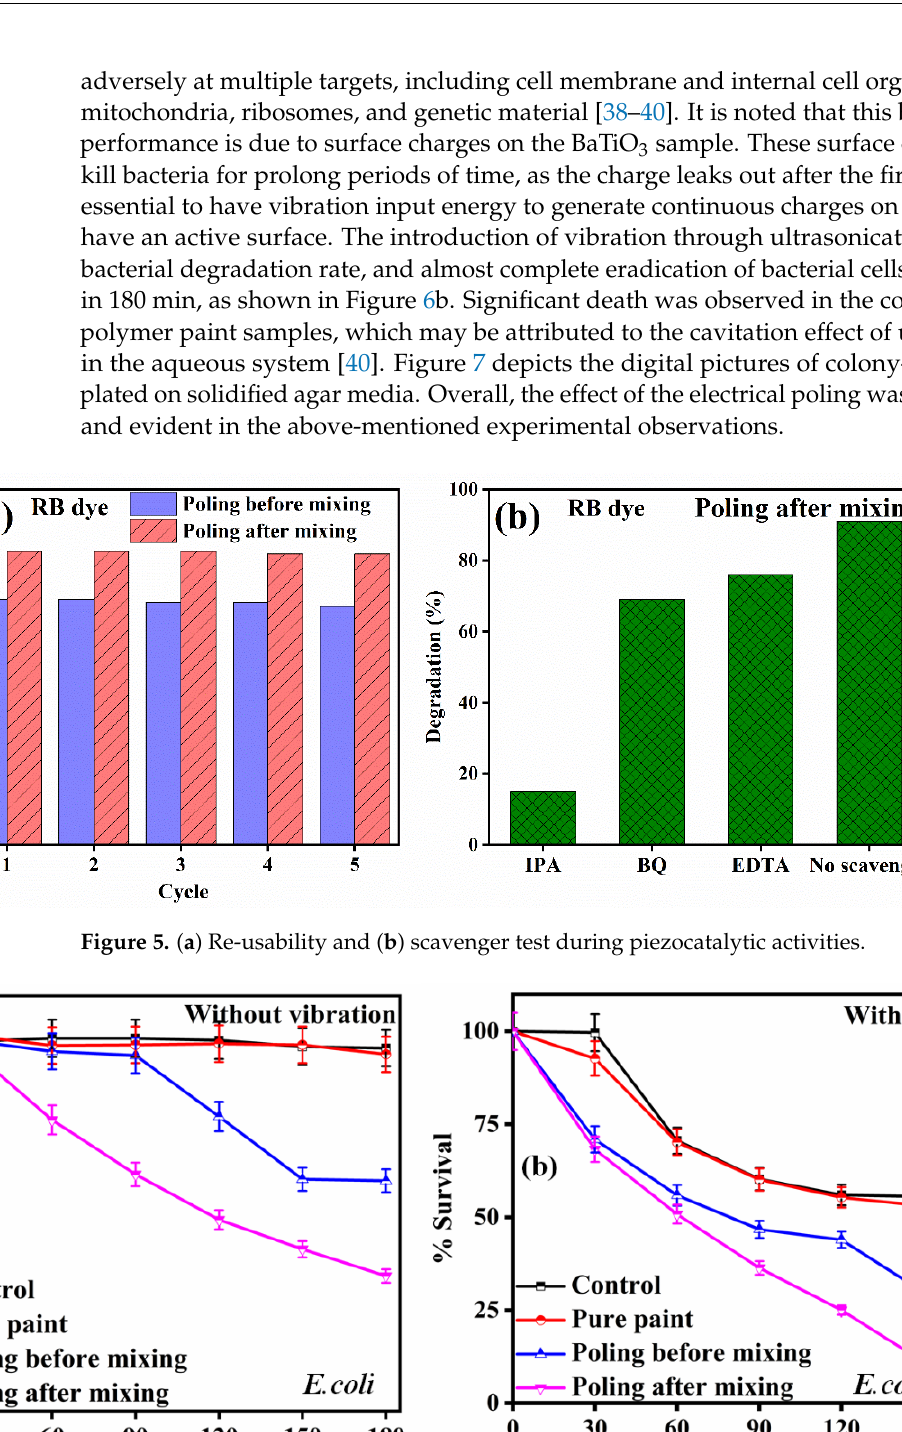
Figure 7. Real-time images of E. coli bacteria cell colonies after 180 min. 3. Experimental Ferroelectric BaTiO 3 (BT) was prepared using a solid-state reaction route. High purity reagents (AR grade, Merck chemicals, Mumbai, India) of BaCO 3 (99% pure) and TiO 2 (99% pure) powders were taken as the raw materials. The mixture was calcined at 1050 °C for four hours to obtain the single-phase BaTiO 3 . The phase formation characterization of the calcined sample was done using the powder X-ray diffraction (XRD) technique employing Cu- Kα radiation (Smartlab, Rigaku , Tokyo, Japan). Polymer (Asian, white paint (50 wt.%)) and BaTiO 3 (50 wt.%) composite samples were prepared. Composite paste was painted (using a brush) on a rectangular frame. A structural study of cement-based composites was performed through X-ray diffraction (Rigaku Smart Lab, Tokyo, Japan) and a scan- ning rate of 2°/min for 2θ ranging betwe en 20° and 70°. The microstructure was obtained